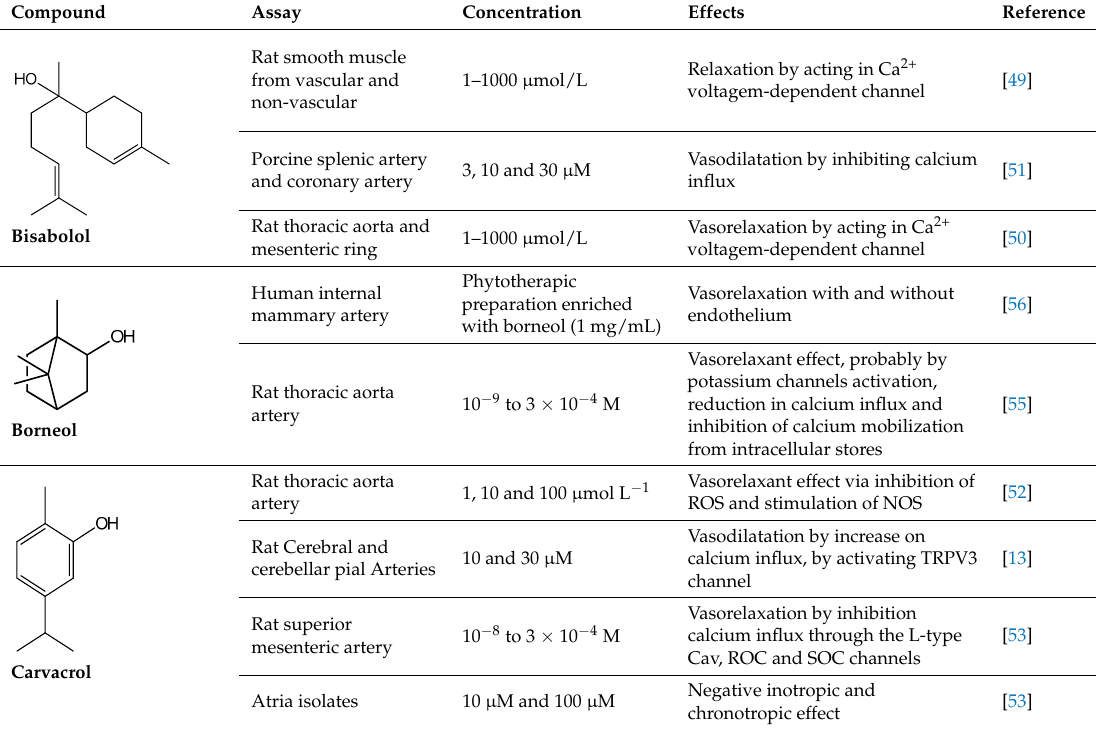
Table 1. In vitro cardiovascular effects of the chemical constituents of essential oils.